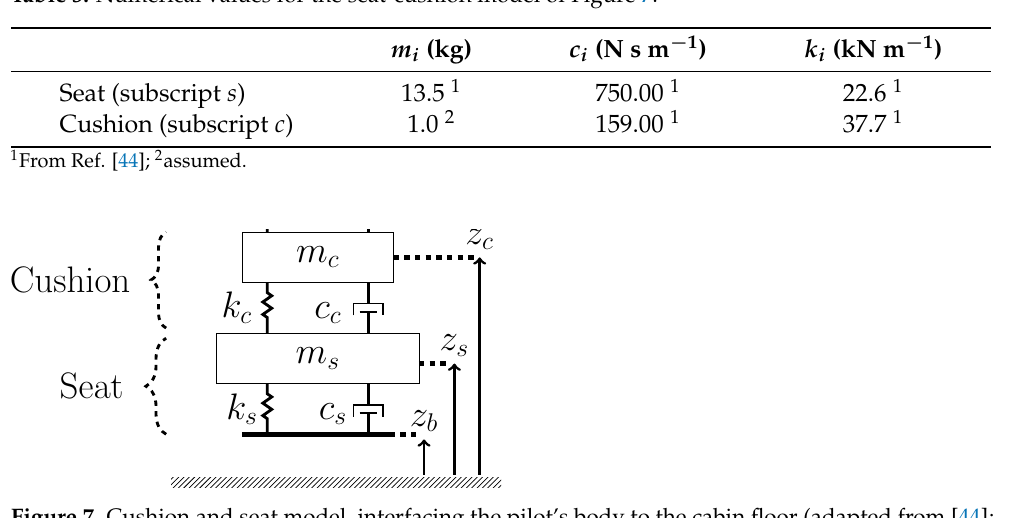
Table 3. Numerical values for the seat-cushion model of Figure 7.